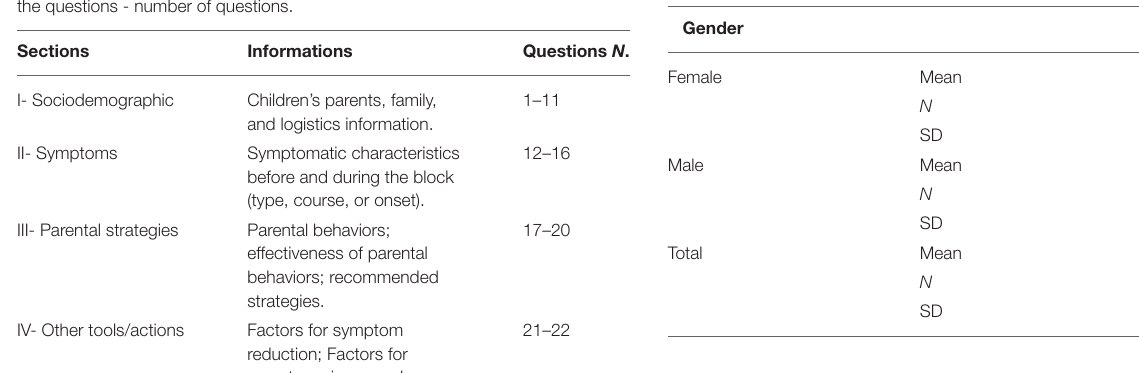
TABLE 2 | Differences between age and region means by